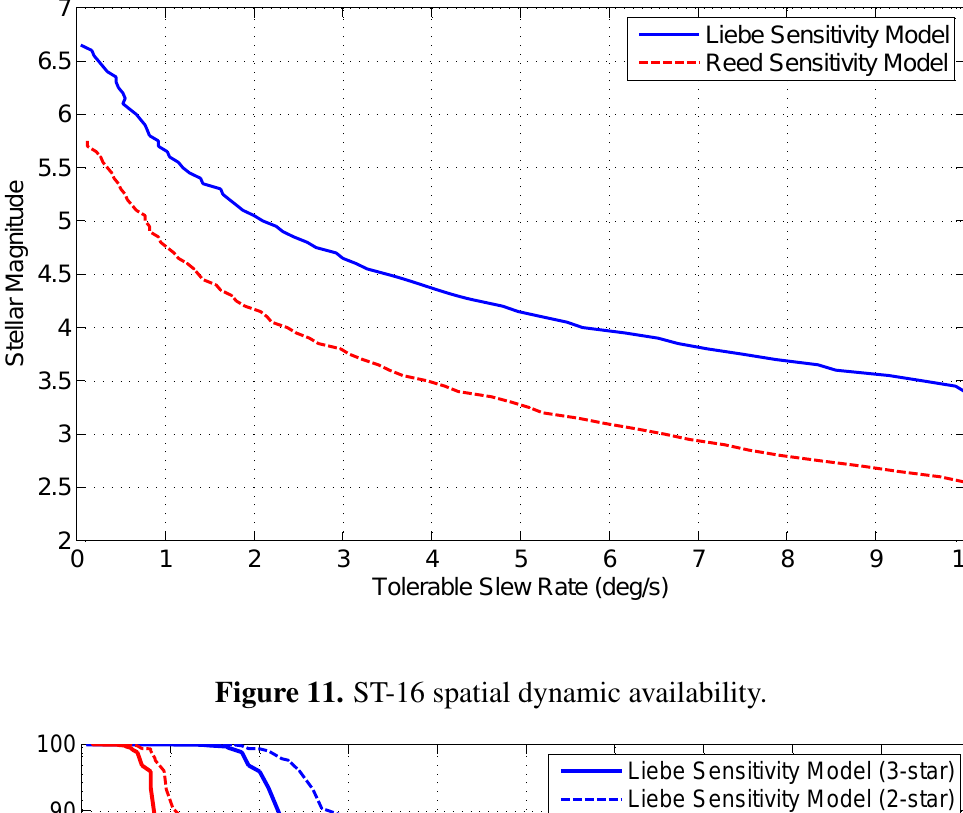
Figure 10. Tolerable slew rates for ST-16 star detection.